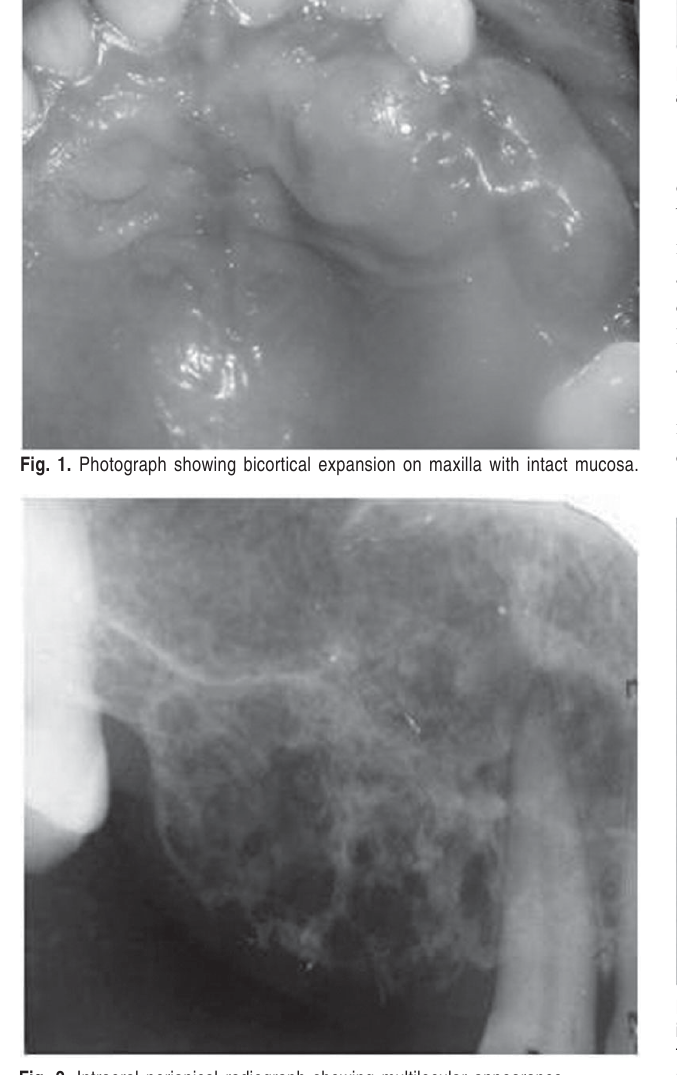
Fig. 2. Intraoral periapical radiograph showing multilocular appearance